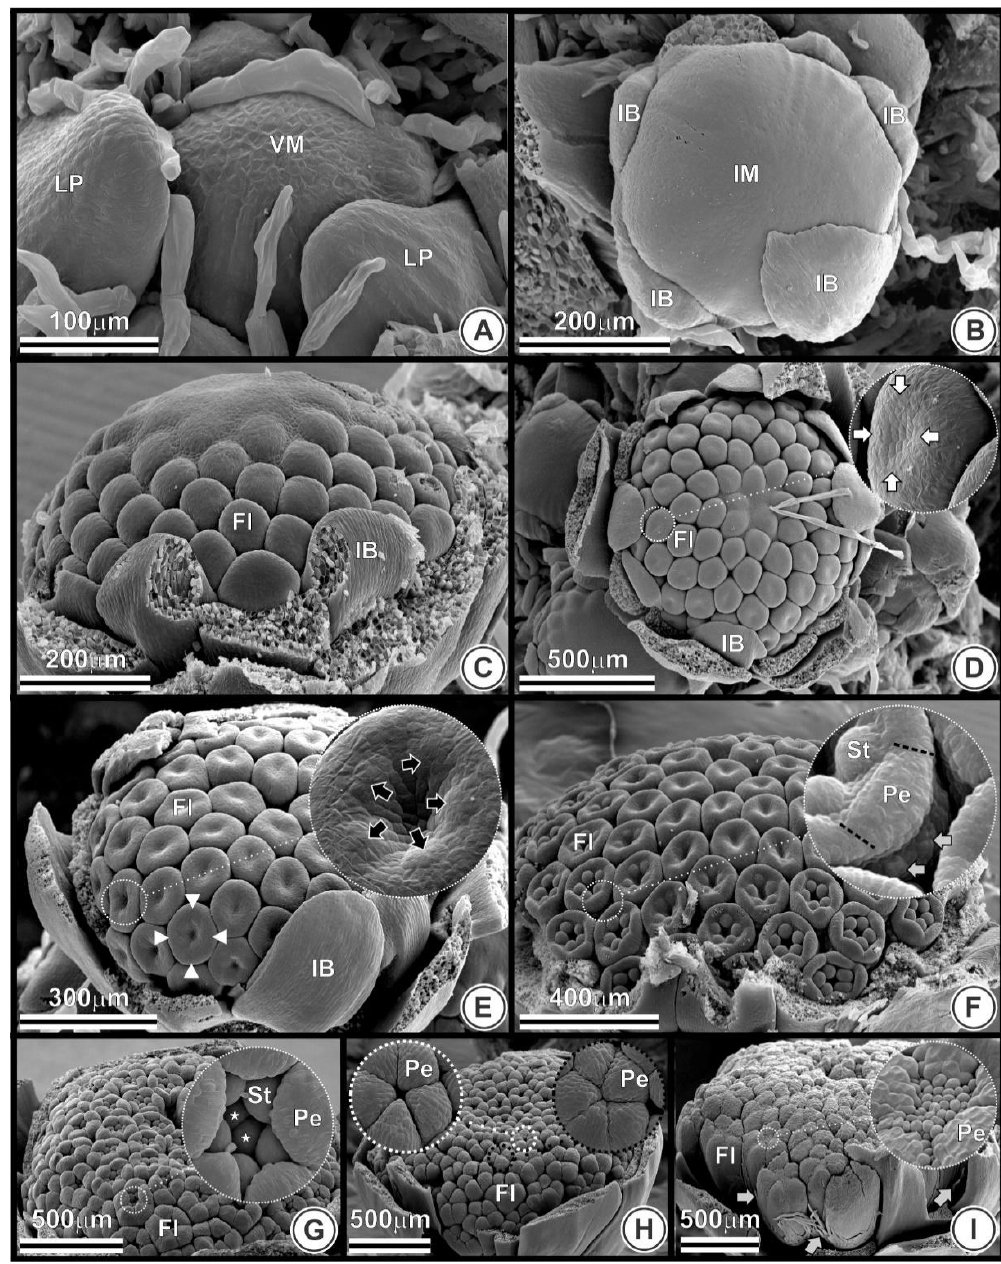
Figure 3. Inflorescence developmental stages in Taraxacum kok-saghyz . Each image shows one of the nine stages (scanning electron microscopy from 5 to 33 days after germination) and morphological aspects of the peripheral flowers in the inflorescence; ( A ) Vegetative meristem, dome-shaped and surrounded by leaf primordial; ( B ) Inflorescence meristem with flattened and widened aspect, involucral bracts, and no sign of flower primordium; ( C ) Flowers arising in an acropetal order; ( D ) Central concavity (white arrows); ( E ) Corolla ring (white arrow heads) and stamens primordia (indicated by black arrows in the detail); ( F ) Petals and five stamens more visible and pappus primordia (gray arrows in the detail). The petals boundaries are showed in the detail (black lines); ( G ) Stamens, carpel primordia (stars) and petals enlarging and touching each other; ( H ) Petals almost (white circle) and fully (black circle) covering the stamens; ( I ) Petals completely touching each other, longer than in previous stages, and pappus (gray arrows). Abbreviations: Co, corolla; CR, corolla ring; Fl, flowers; IB, involucral bracts; IM, inflorescence meristem; LP, leaf primordia; Pa, pappus; Pe, petals; St, stamens; VM, vegetative meristem.